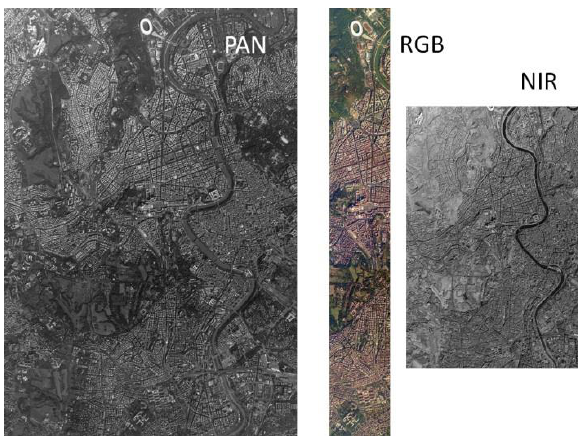
Figure 9: The 3 image planes of one UC-G frame showing the city of Rome, Italy -- flight direction from left to right. (NIR image is reduced) 6.